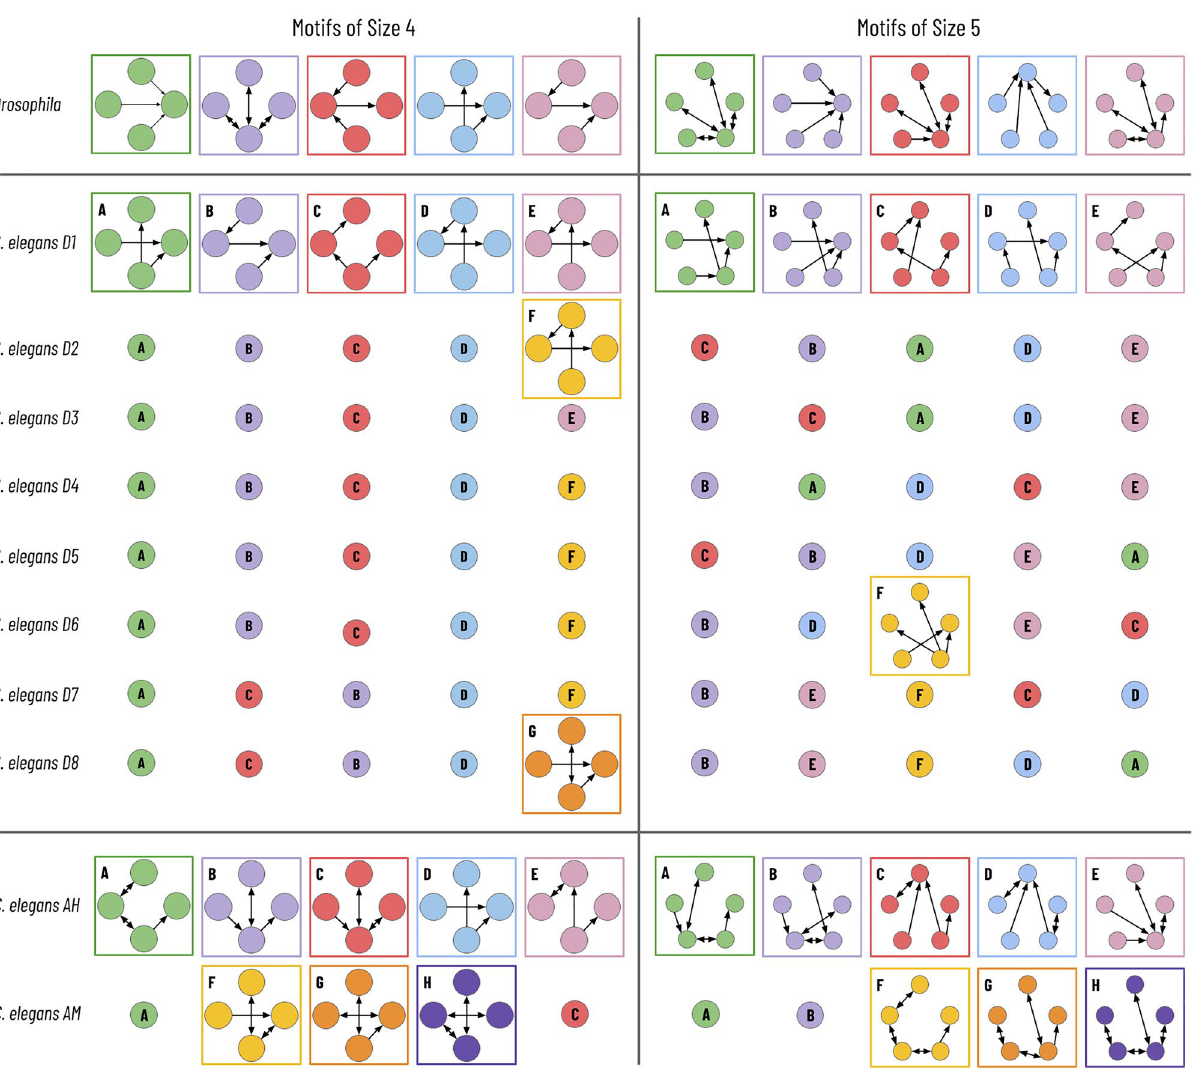
Figure 4. Most frequent motifs of size 4 and 5. Here, we summarize the five most common motifs of sizes four and five for the eleven connectomes. Within each of the three datasets, motifs with the same color and letter designation are